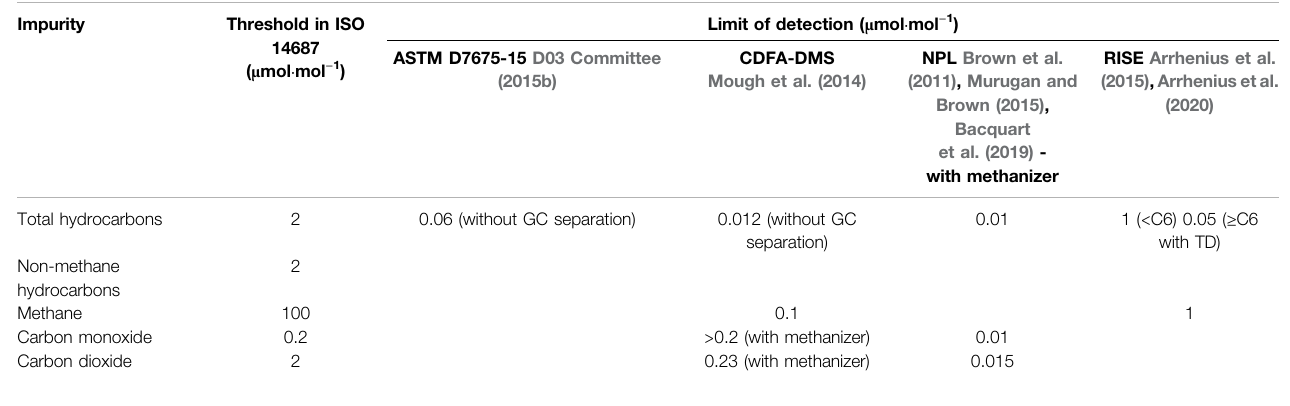
TABLE 5 | Detection limit per impurity with GC-FID for ASTM D7675-15, CDFA-DMS, NPL and RISE.